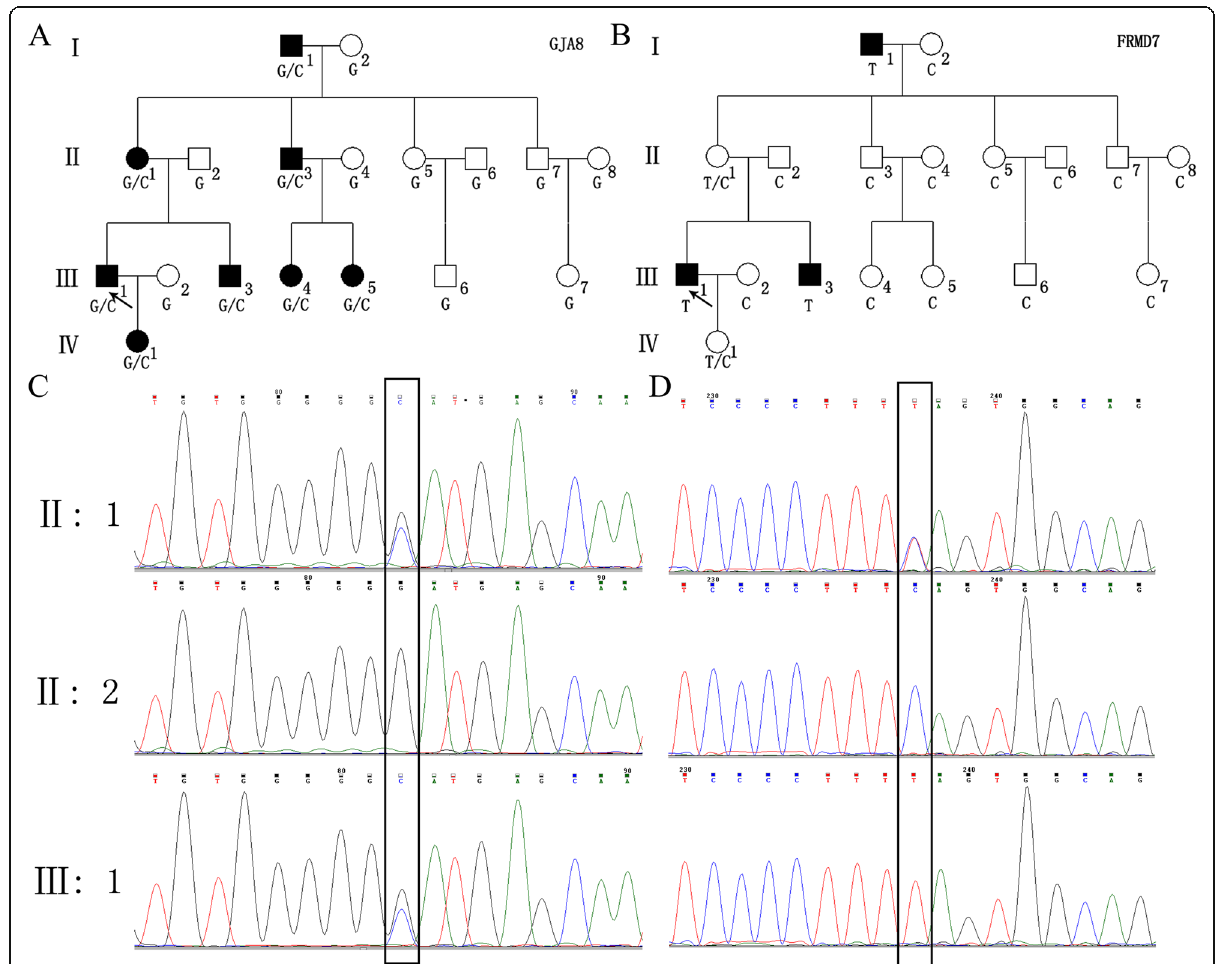
Fig. 2 GJA8 and FRMD7 mutations in this family. a and c The GJA8 heterozygous mutation c.139G>C was found in all patients and likely is responsible for the autosomal dominant pattern of inheritance of congenital cataracts in this family. b and d The FRMD7 splicing variant c.498-3C>T was found in I:1, III:1 and III:3; thus, this variant likely plays a role in CN ’ s X-Linked recessive inheritance